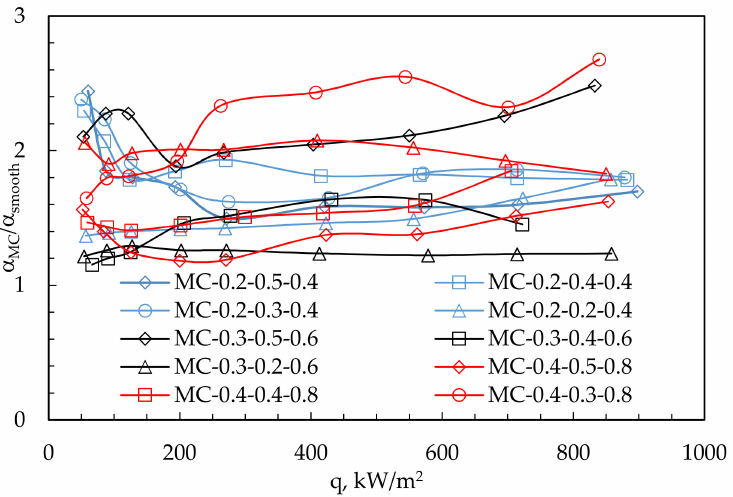
Figure 8. Heat transfer coefficient enhancement in nondimensional form for MC surfaces below the CHF for plain and smooth